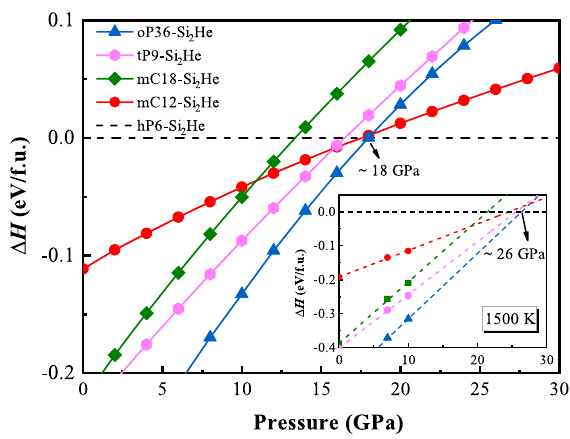
Fig. 1 Relative enthalpies of the predicted Si 2 He phases. Enthalpy of oP36-Si 2 He, tP9-Si 2 He, mC18-Si 2 He, and mC12-Si 2 He relative to previously proposed hP6-Si 2 He 53 as a function of pressure at 0 and 1500